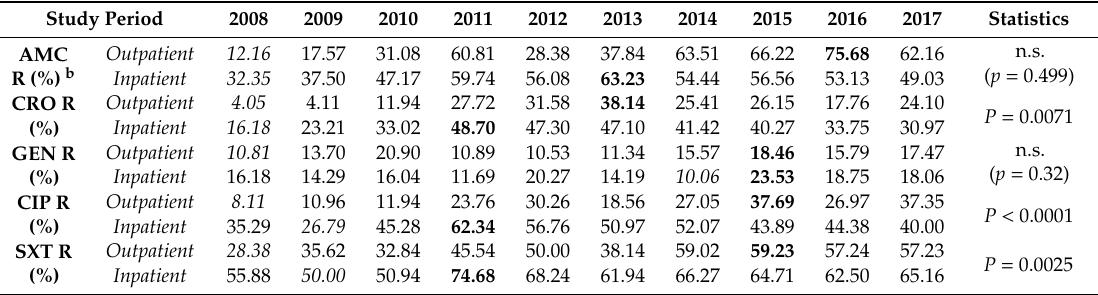
Table 2. Percentage of resistant strains to indicator antibiotics from inpatient and outpatient departments (2008–2017) a .